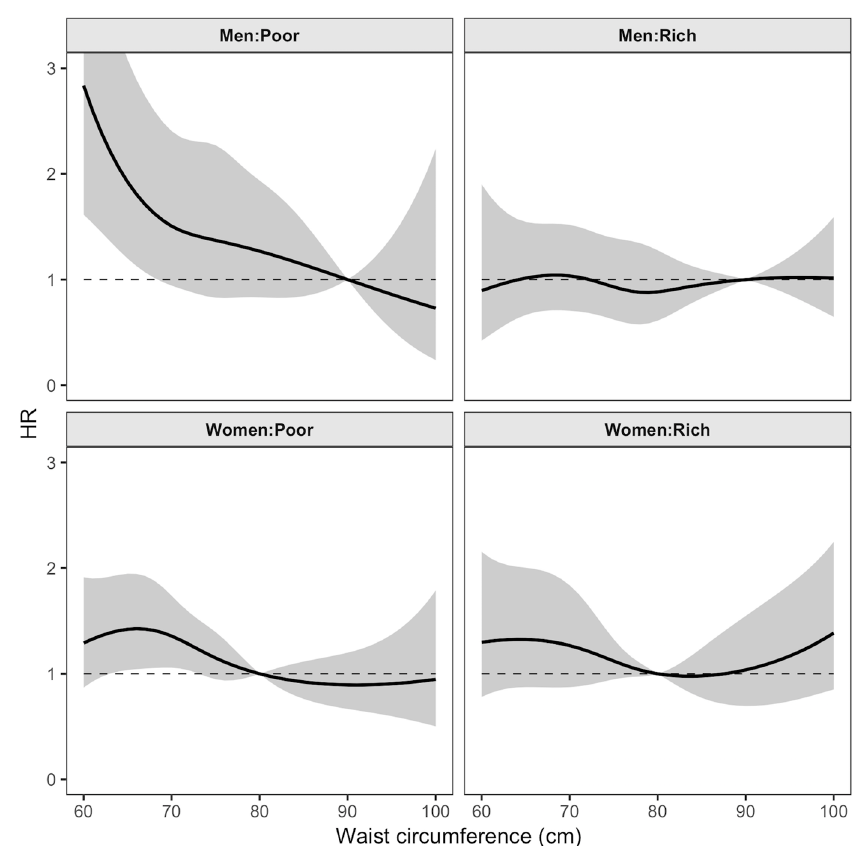
Figure 3. Plots of mortality hazard ratio (HR) with 95% confidence interval (shaded regions) from multivariate adjusted Cox regression analysis with restricted cubic splines of waist circumference. WHO-INDEPTH SAGE Purworejo longitudinal data (2007–2010).